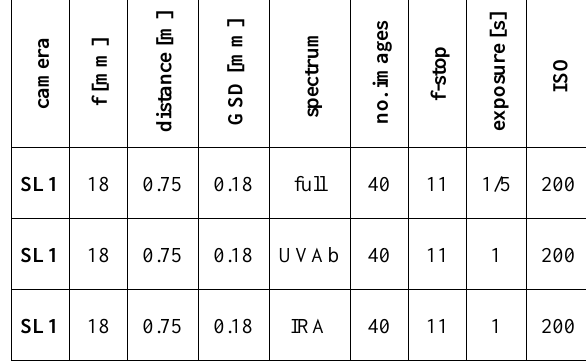
Table 3: details of image datasets for